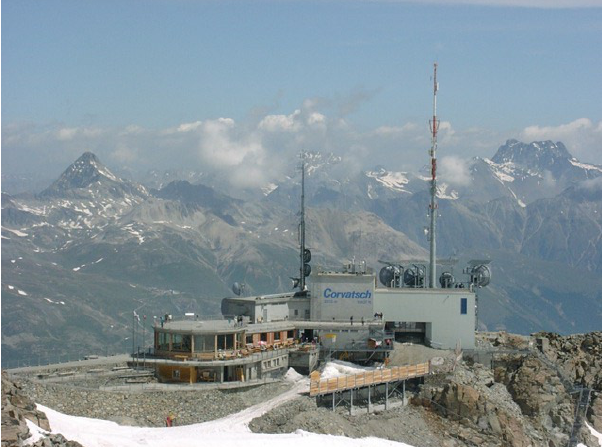
Fig. 3. The height of the meteorological station at Piz Corvatsch is assumed uncertain, ranging from 0.5 to 16m. Within mountain topography, the actual height in relation with the surroundings at the top of a mountain cannot be accurately determined. In the figure, the meteorological station is just above the “tsch” of